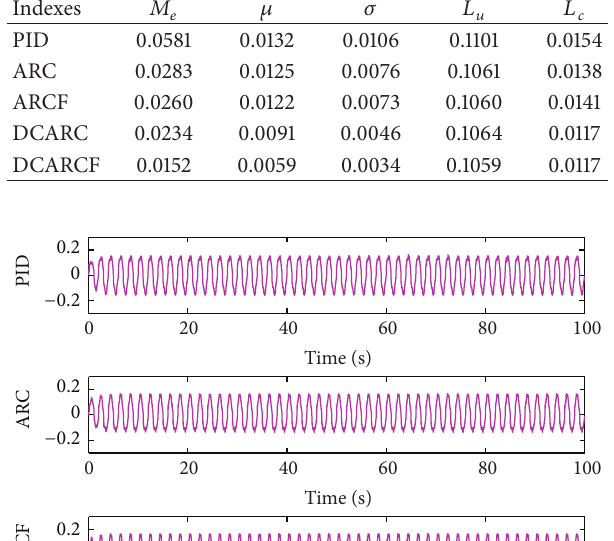
Figure 8: Tracking errors of five controllers during the last two cycles.